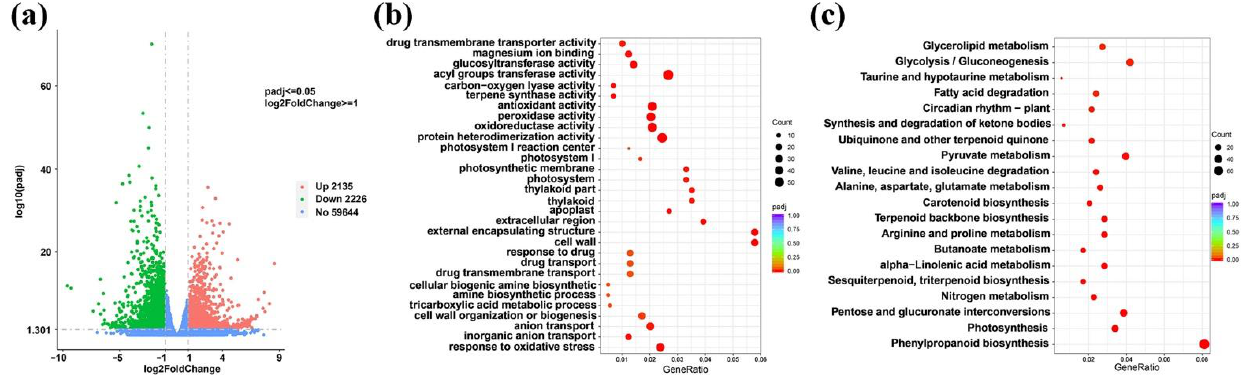
Figure 3. The differentially expressed genes and enrichment analysis of the DEGs under root illumination in TM-1. ( a ) the volcanic map of the DEGs under root illumination (RI), the green dots represent the downregulated genes, the red dots represent the upregulated genes, and the blue represents genes were not significantly differentially expressed, significance is set at padj < 0.05; ( b , c ) the GO and KEGG enrichment results of the DEGs under RI.